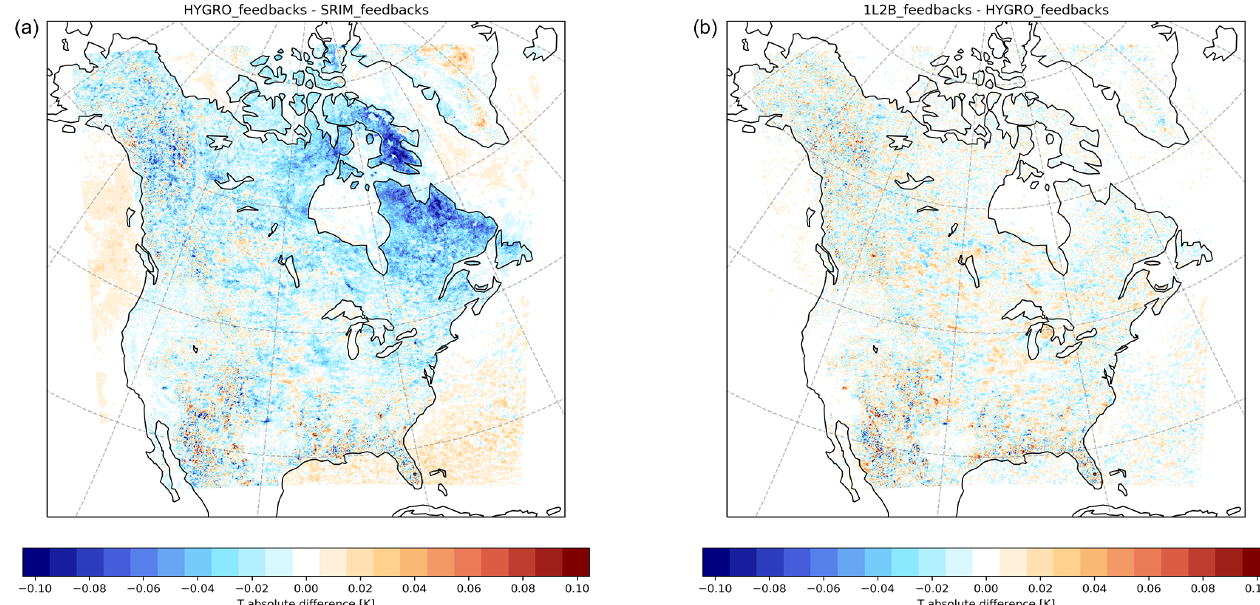
Figure 11. (a) Mean difference in surface temperature between the HYGRO_feedback and SRIM_feedback simulations and (b) mean difference in surface temperature between the 1L2B_feedback and HYGRO_feedback